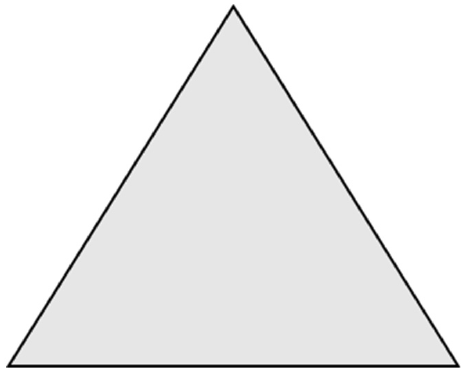
Figure 3. The social pyramid of the autocratic